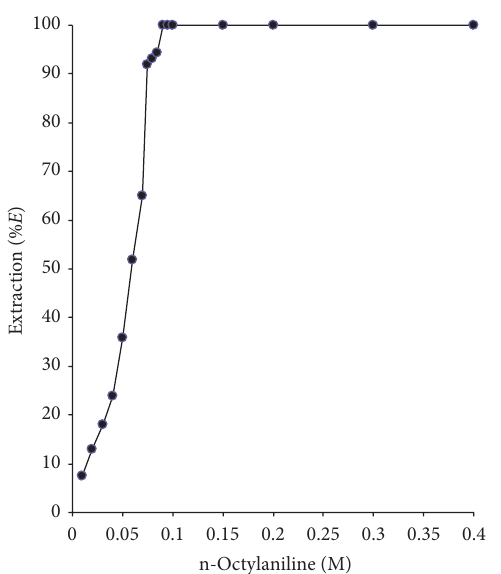
Figure 3: Extraction of platinum(IV) (150 𝜇 g/mL) at pH 0.50 from 0.01M ascorbic acid medium as a function of n-octylaniline concentration.